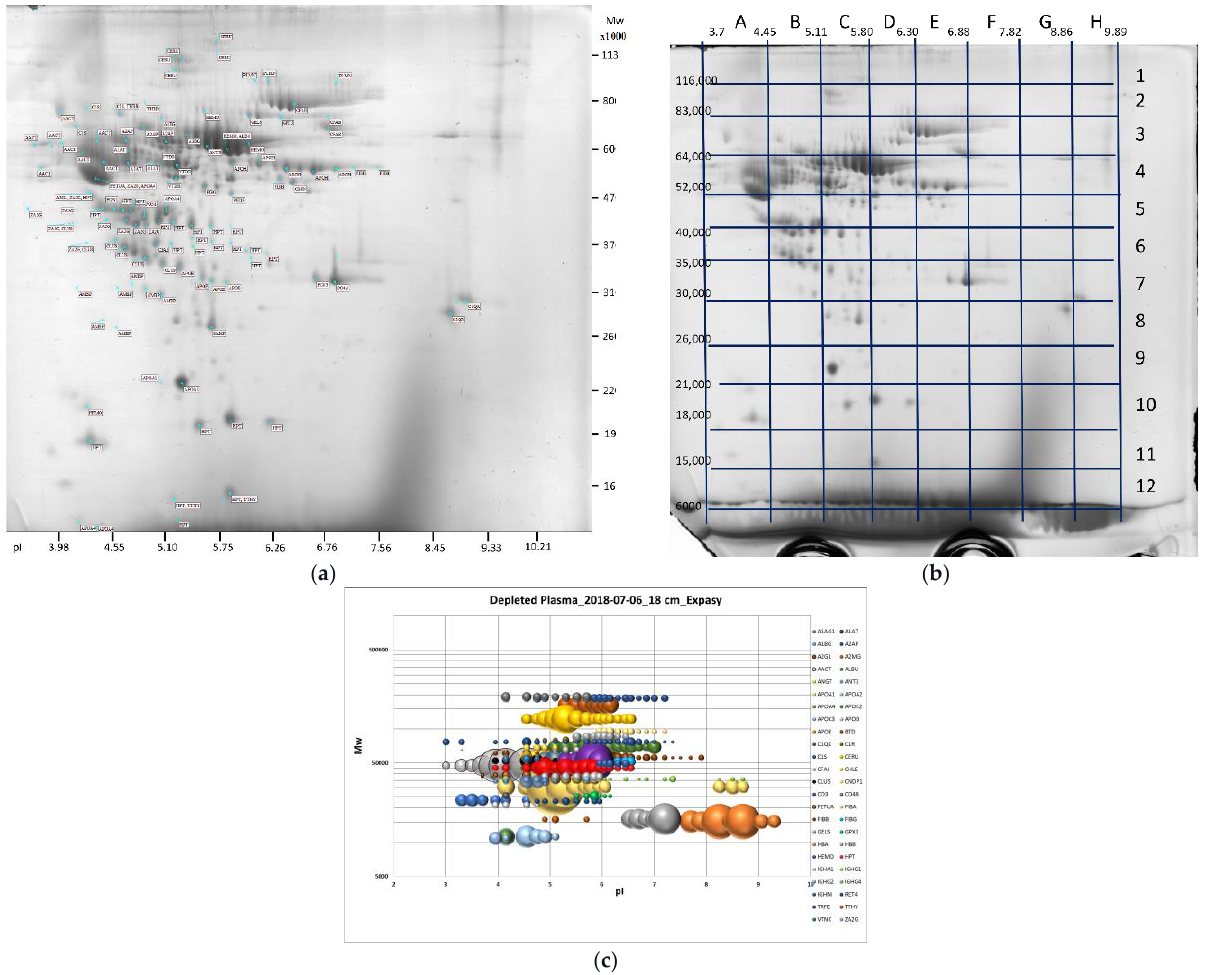
Figure 1. Two-dimensional electrophoresis image of depleted plasma proteins taken for the sectional analysis. ( a ) A classical annotated 2DE image of plasma proteins; ( b ) a sectional analysis of the gel presented in ( a ). The stained gel was divided into the sections with the predetermined coordinates, and each section was treated and analyzed by LC ESI-MS/MS (see Materials and Methods, Section 4.2, 2DE); ( c ) a semi-virtual 2DE of the major plasma proteins. The plasma proteins were separated by isoelectrophocusing (IEF), using the 18-cm Immobiline DryStrip 3 – 11 NL. The strip was cut to 36 equal sections, and each section was treated and analyzed by LC ESI-MS/MS (see Materials and Methods, Section 4.2, 2DE). According to the abundance (emPAI) of each protein in the sections, the graph was plotted. The ball size is proportional to the protein emPAI in each section. Table 1. The most abundant plasma proteins related to cancer. Concentration (µg/mL) is presented according to [16] if otherwise not shown. Abundance (emPAI) was calculated according to data from the semi-virtual 2DE (Supplementary Table S 1). In the column “Cancer”, the references for cancer-related data are shown (the details are in the Supplementary File).